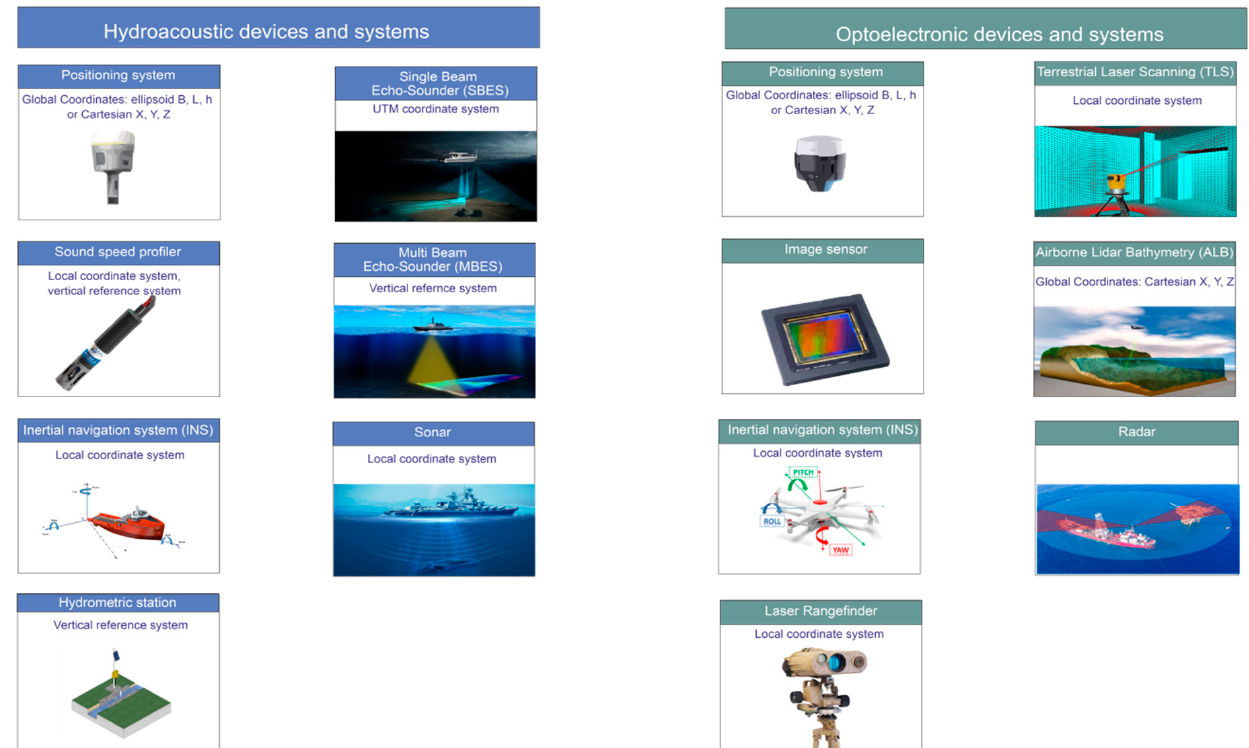
Figure 1. A diagram presenting hydroacoustic (blue colour) and optoelectronic (green colour) devices and systems.